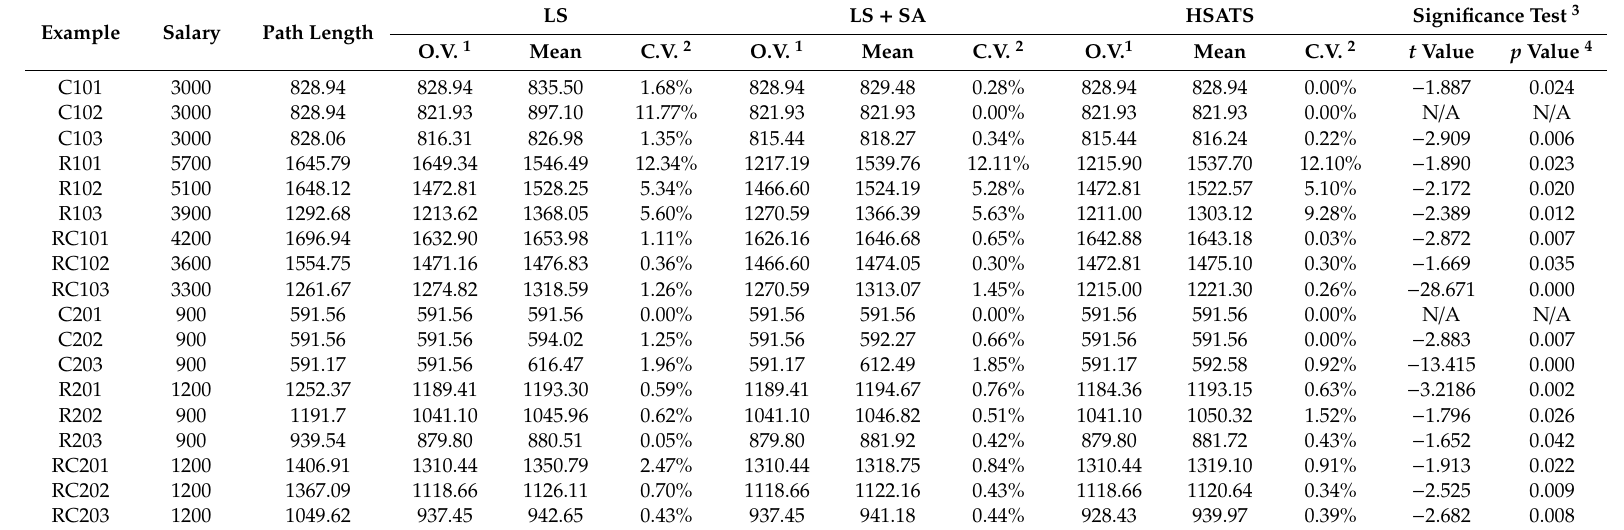
Table 10. Results of di ff erent algorithm strategies.